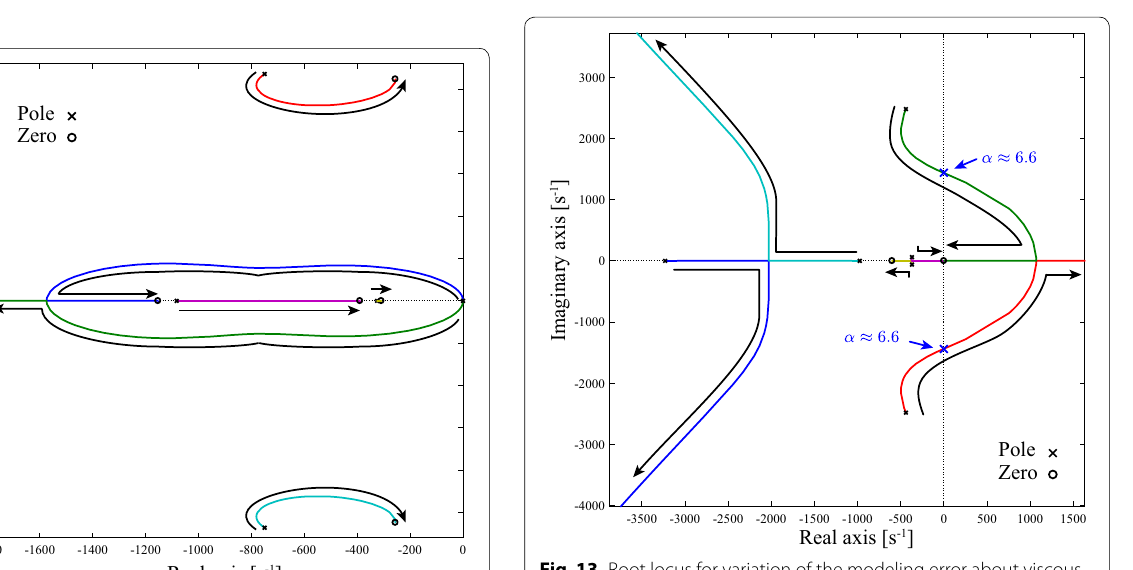
Fig. 13 Root locus for variation of the modeling error about viscous